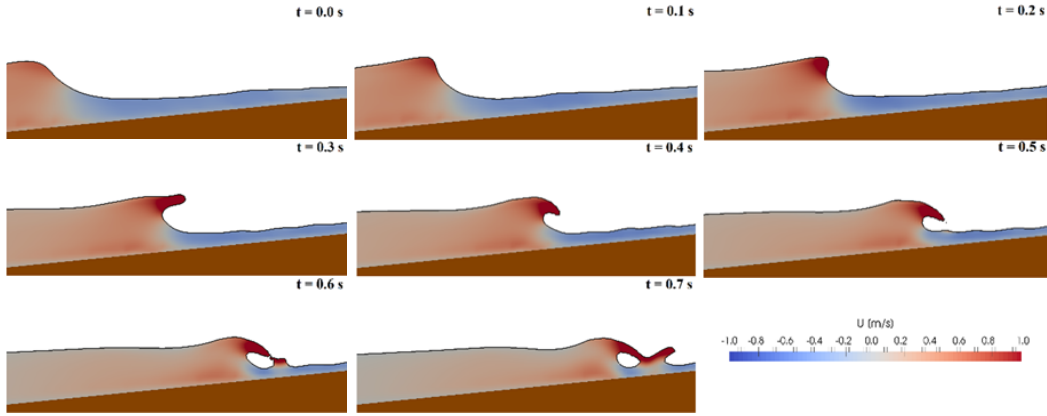
Figure 16. Plunging breakers reproduced with CFD at different time instants.